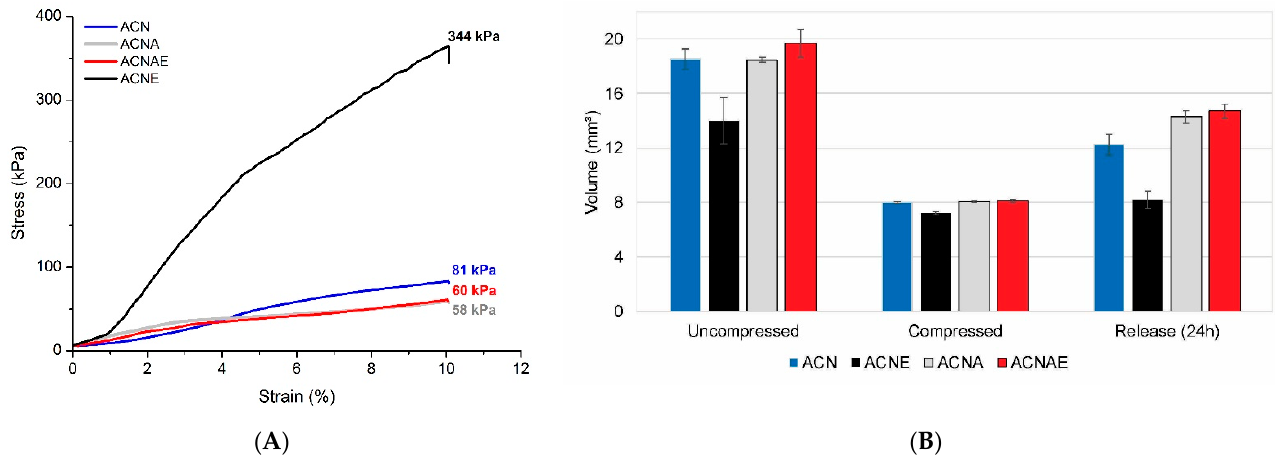
Figure 5. Representative stress–strain curves of the NFC-based hydrogels ( A ); Uncompressed, compressed, and release (24 h) NFC-based hydrogels volume ( B ).